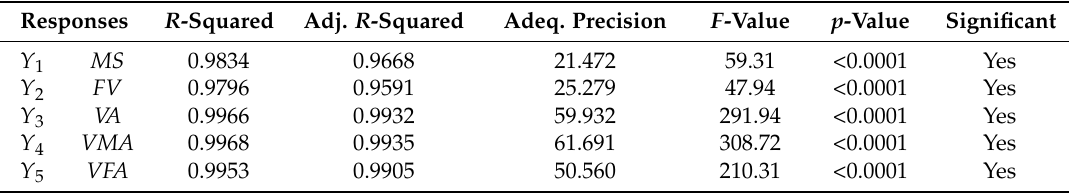
Table 6. ANOVA results for quadratic models of modified asphalt mixture.